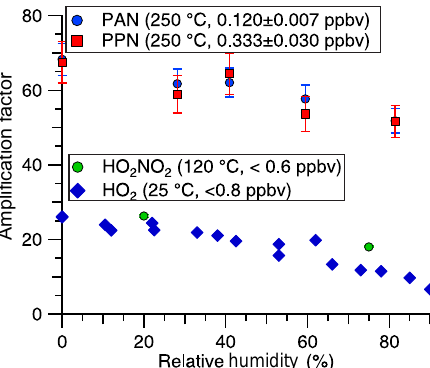
Figure 10. TD-PERCA-CRDS amplification factors as a function of PAN, PPN, and PNA mixing ratio. Errors bars correspond to ± 1 σ standard deviation. Mixing ratios of NO and ethane were 500 ± 50ppbv and ∼ 1.6%, respectively. The grey underlay indi- cates the linear range. The dark green line corresponds to 26.3 ± 0.4 (slope of data shown in Fig.